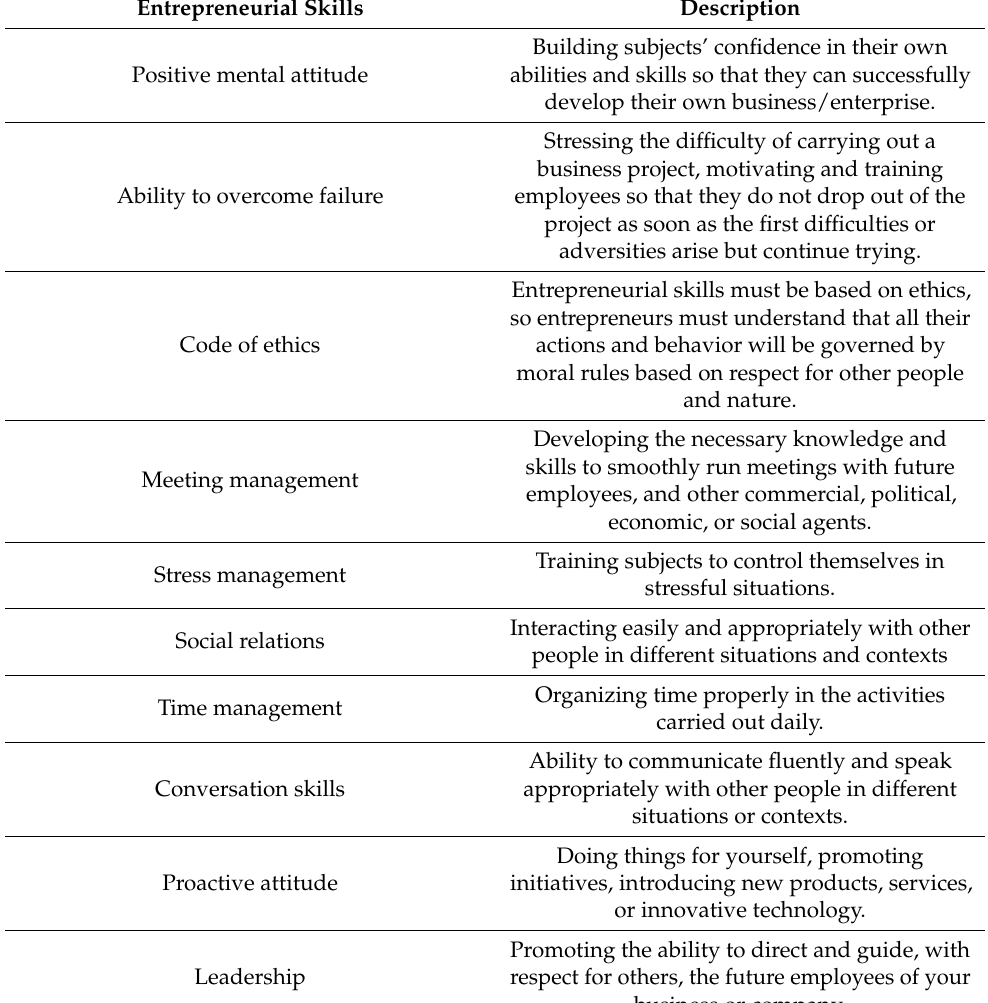
Table 1. Types of entrepreneurial skills to be acquired and their